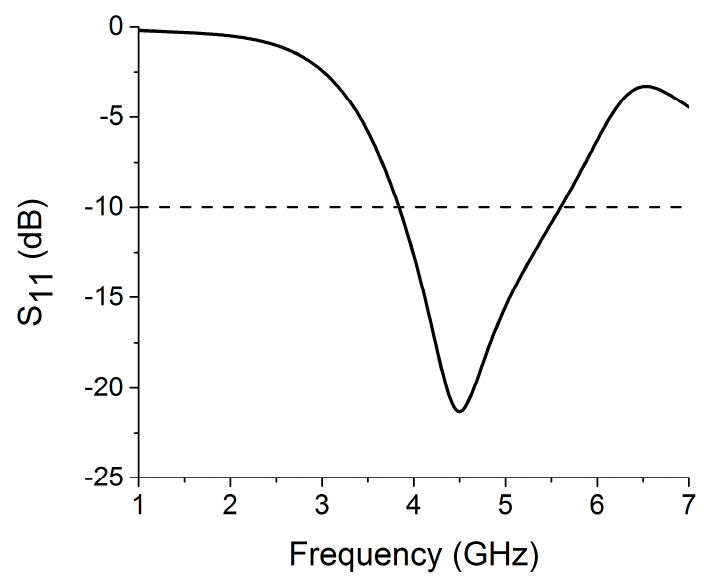
Figure 2. Single antenna’s simulated reflection coefficient.